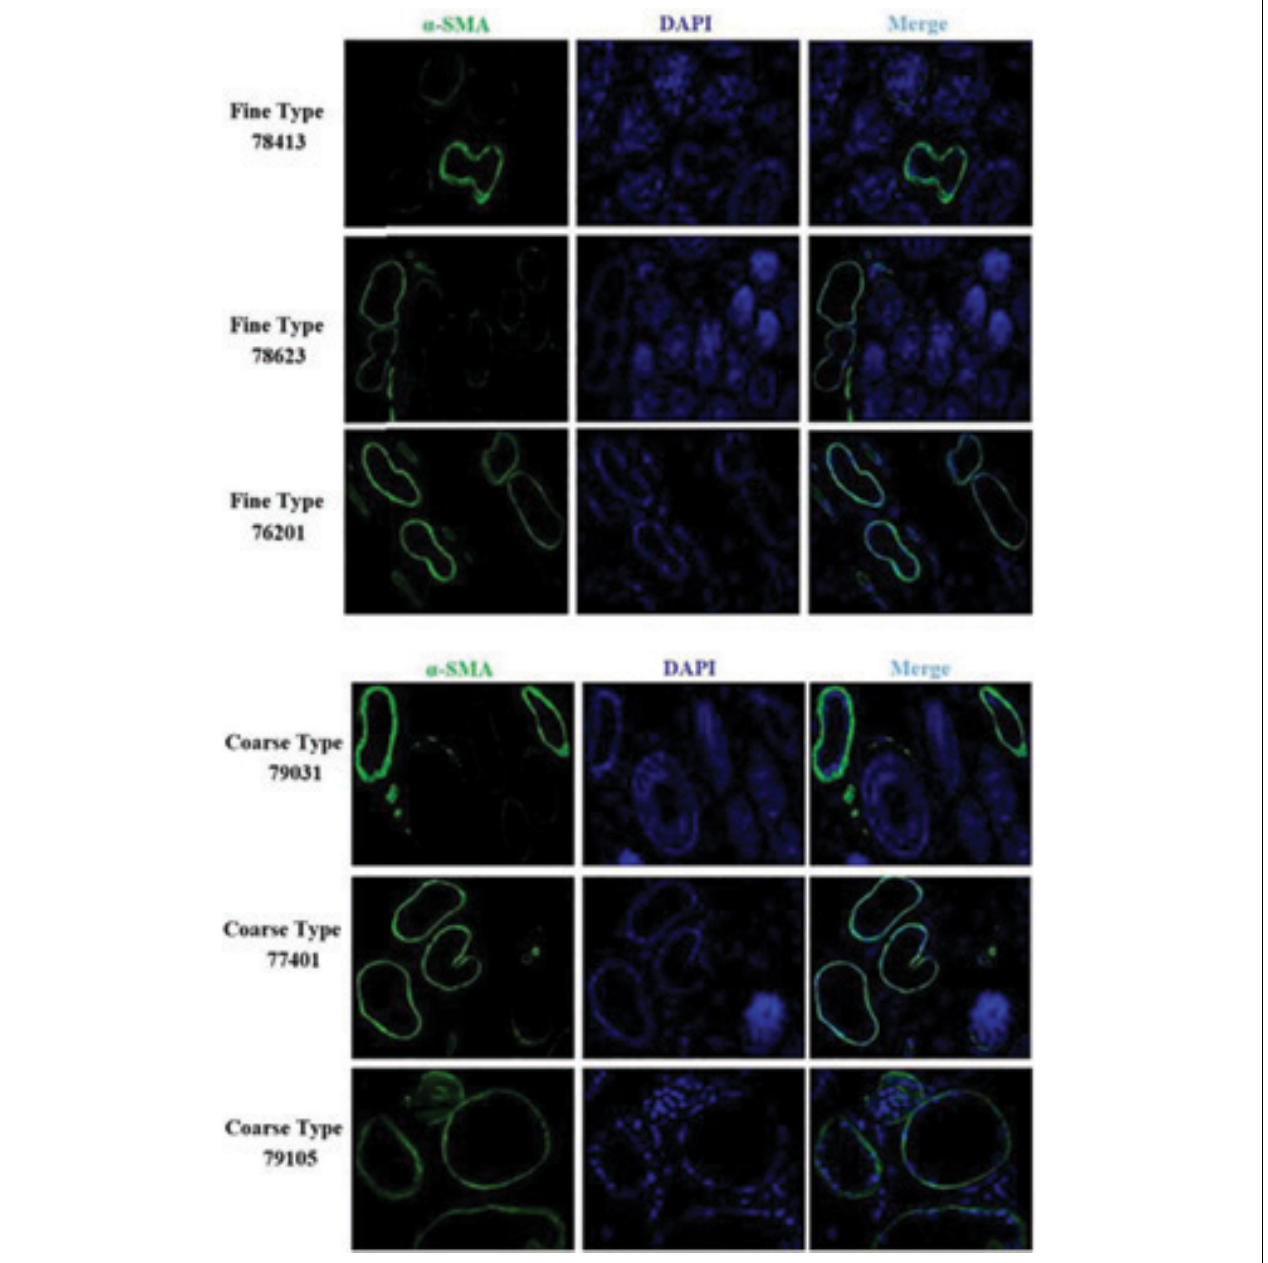
FIGURE 11 | IF results of ACTA2 ( α -SMA ) in FT-LCG and CT-LCG skin tissues (200x). ACTA2 is basically expressed in SHFs.